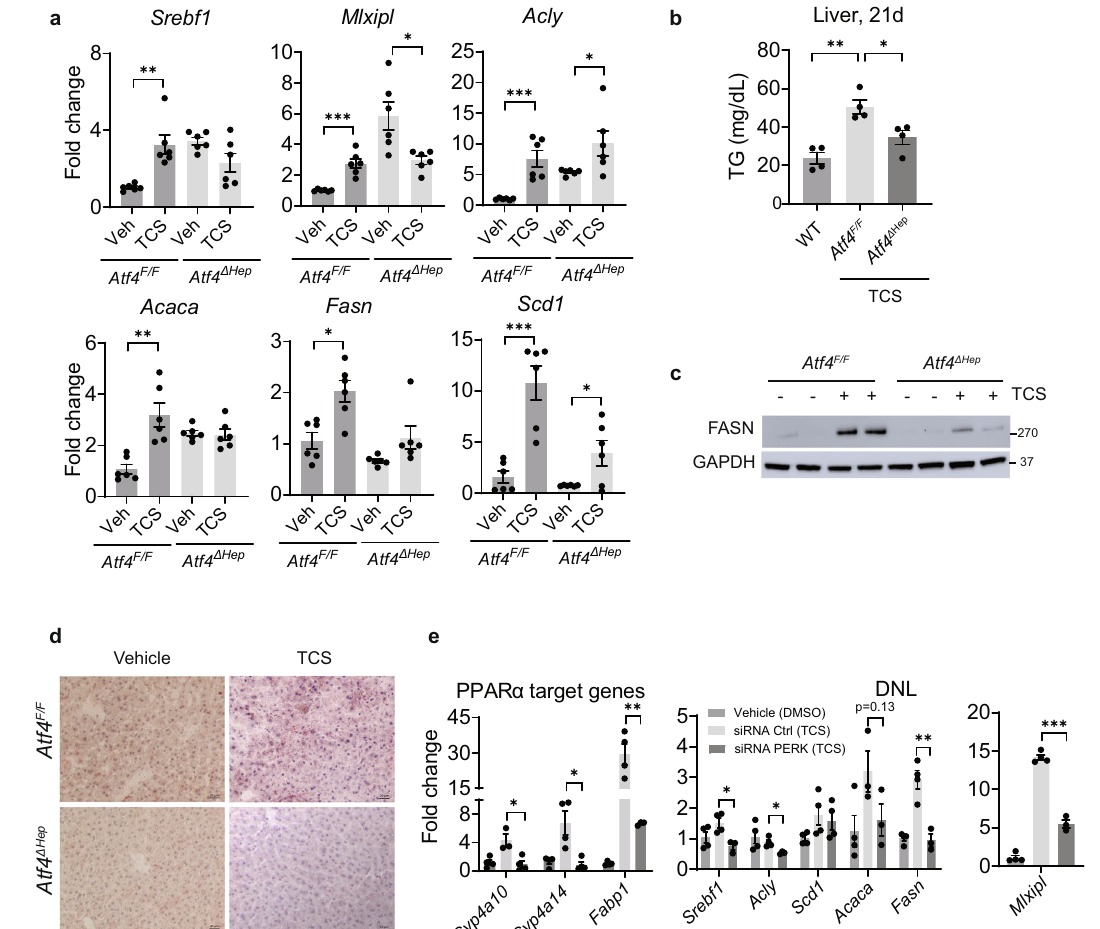
Fig. 5 | ATF4 controls DNL in liver of TCS-treated mice. Atf4 F/F and Atf4 Δ Hep mice breastfed with vehicle or through lactational delivery of TCS for 21 days. a Expression of hepatic lipogenic genes, n =6 mice per group. b Measurement of liver triglycerides (TG), n =4 mice per group. c IB analysis of FASN in liver lysate from 21-day old mice ( n =3 mice per group). d Frozen liver sections were stained